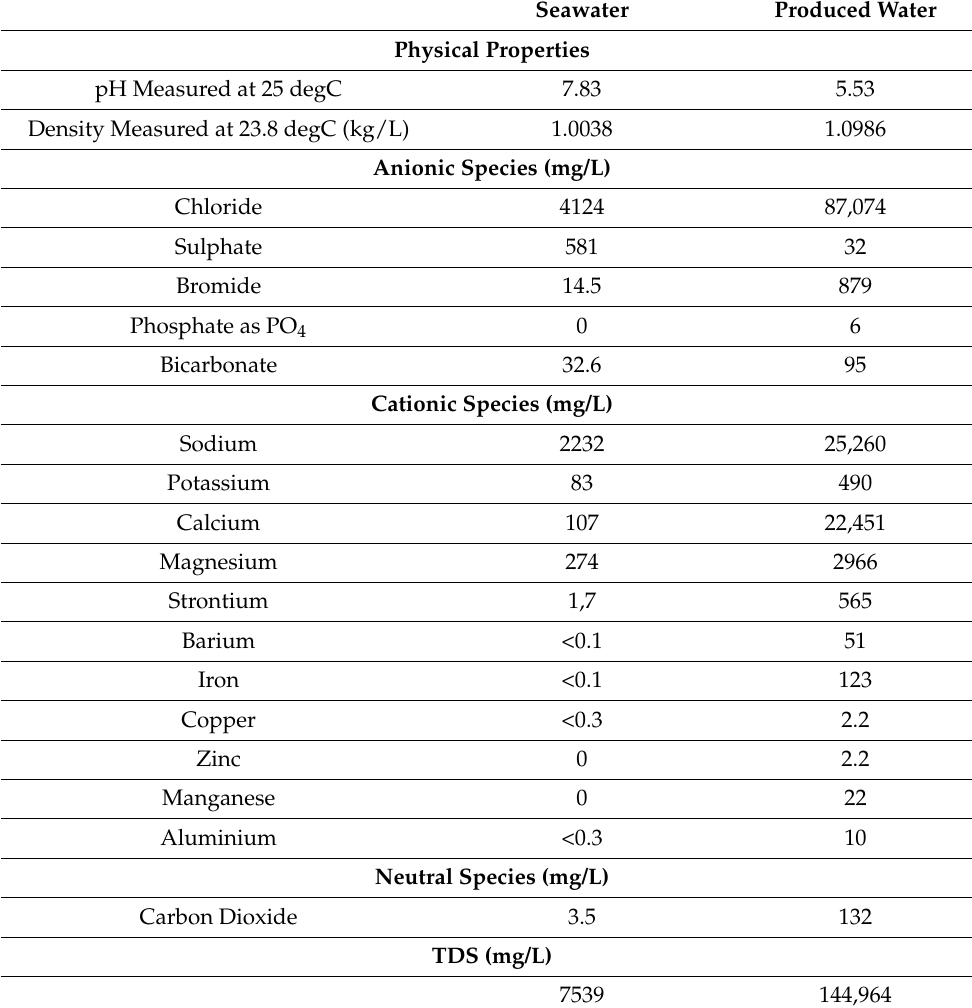
Table 1. Seawater and produced water